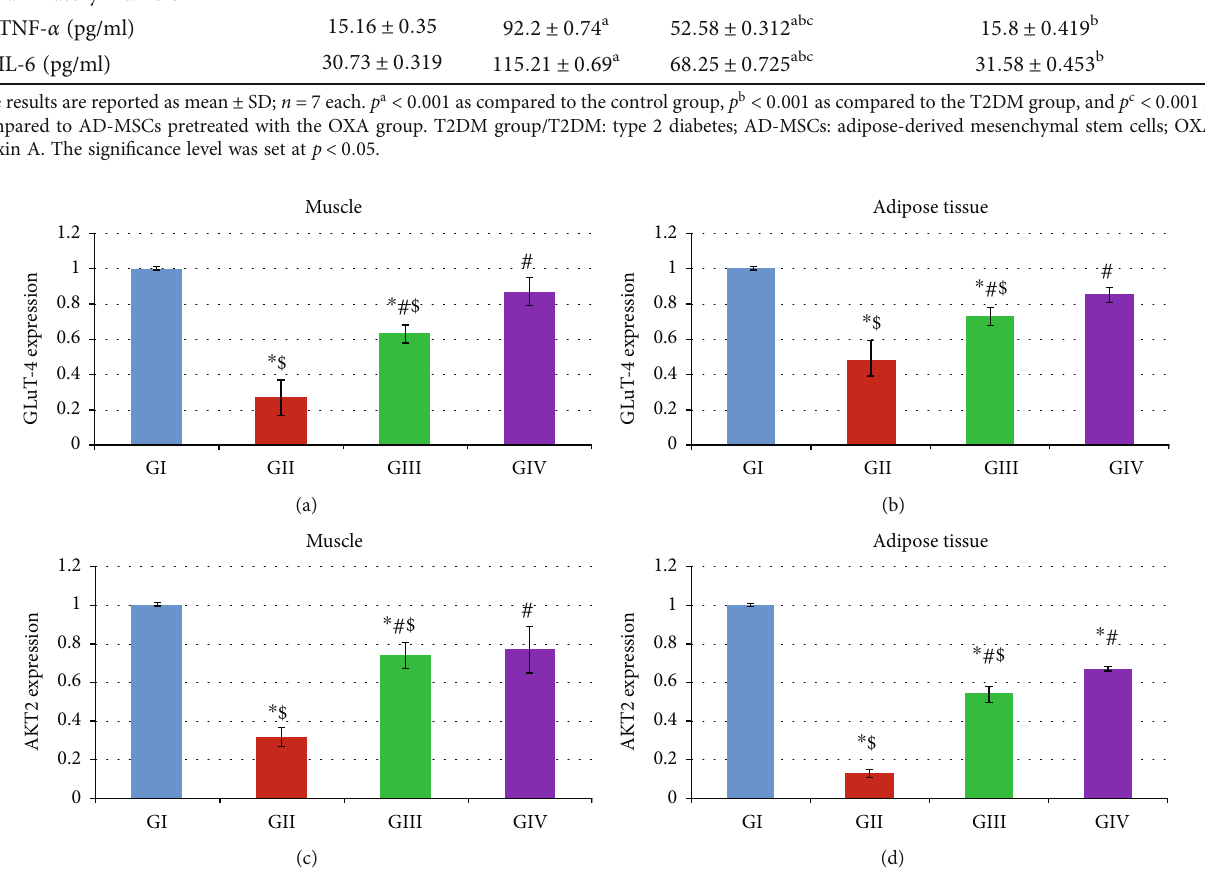
Figure 4: The e ff ect of administration of AD-MSCs and AD-MSCs pretreated with OXA on the gene expression levels of GLUT-4 in the (a) muscle and (b) adipose tissue and AKT2 in the (c) muscle and (d) adipose tissue of T2DM rats. Results are expressed as mean ± SD , ( n = 7 ). ∗ Signi fi cant as compared to the control group (GI). # Signi fi cant as compared to the T2DM group (GII). $ Signi fi cant as compared to AD- MSCs preconditioned with the OXA group (GIV). GI: normal control group; GII: diabetic group; GIII: diabetic group treated with stem cells; GIV: diabetic group treated with stem cells preconditioned with OXA. p < 0 : 05 is adopted as a signi fi cant